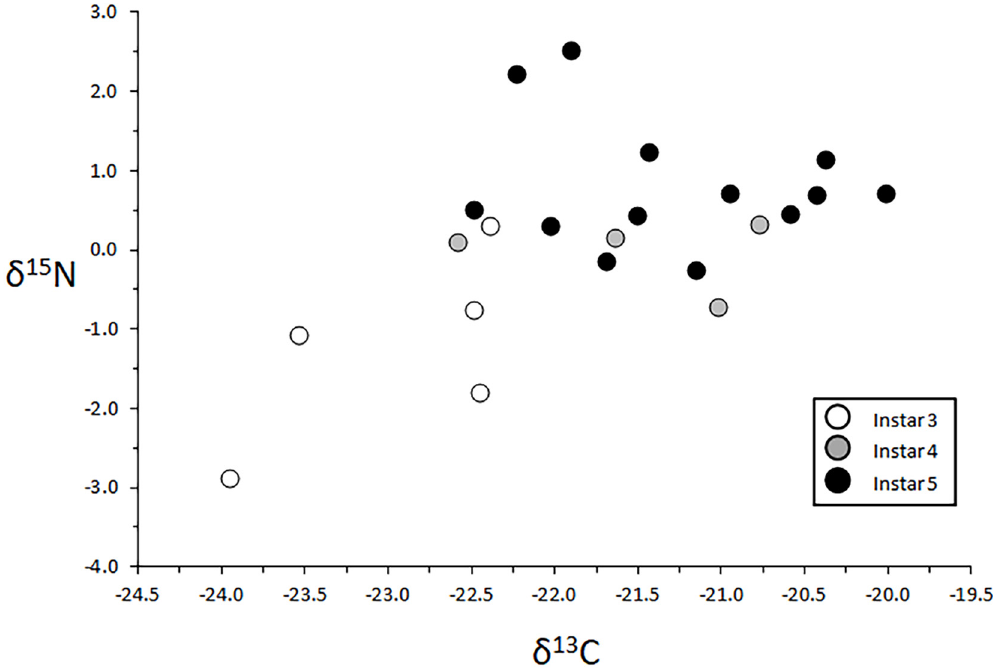
Figure 10. δ 13 C and δ 15 N data for 3rd, 4th, and 5th instar larvae from Site 3.